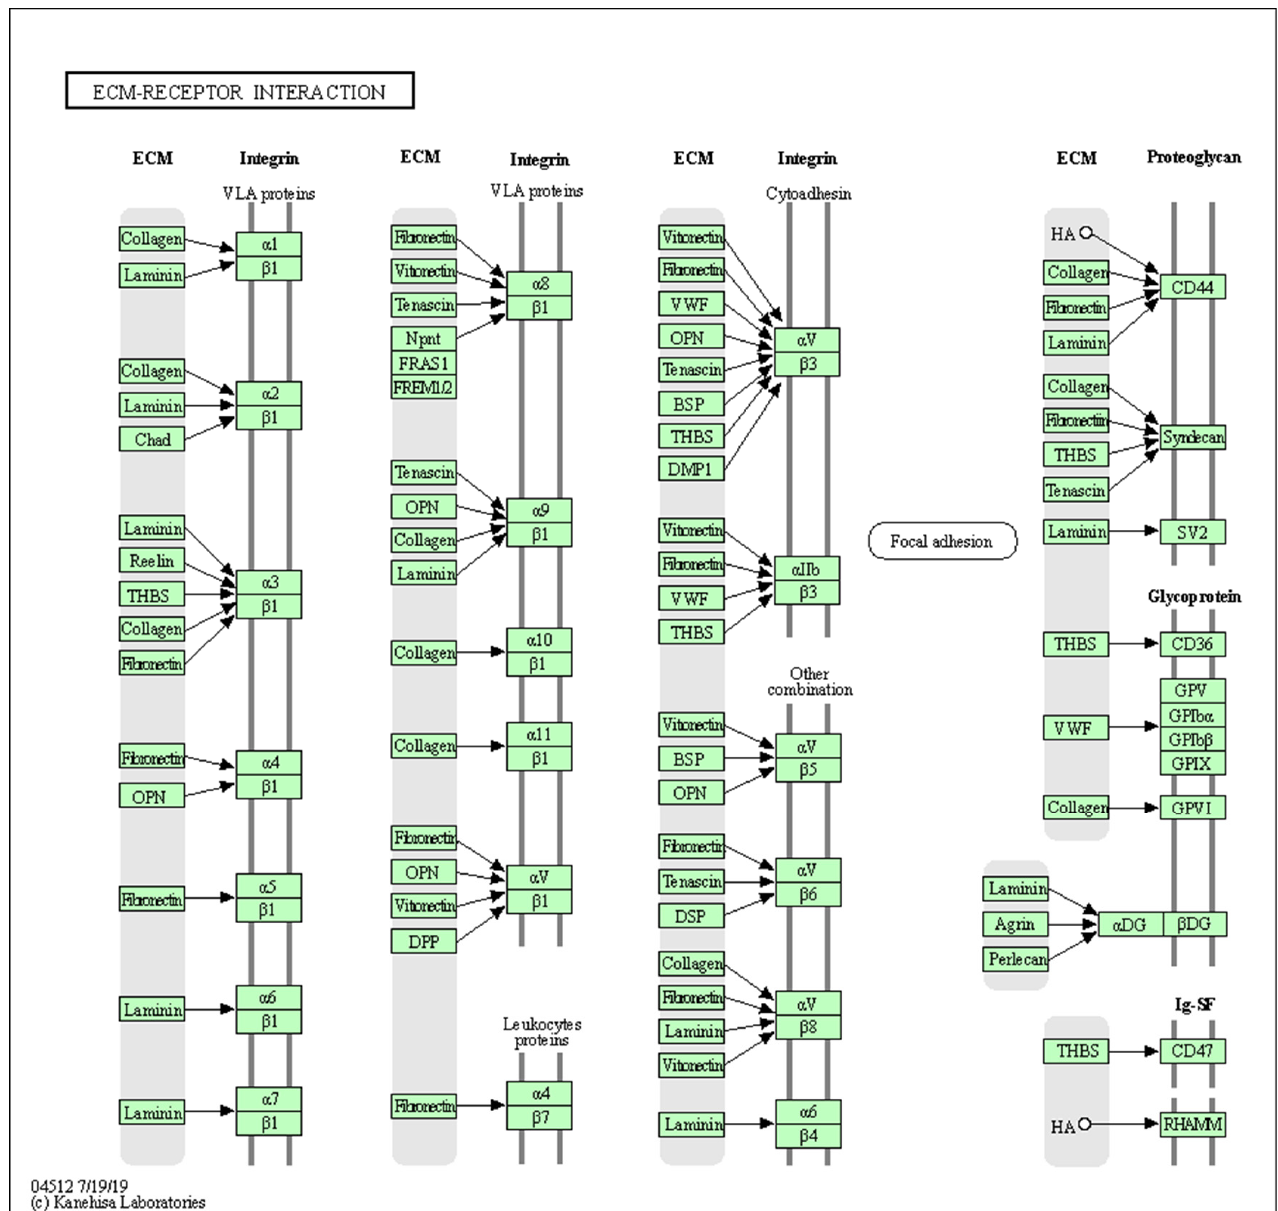
Figure A2. ECM-receptor interaction signaling pathway, KEGG pathway. KEGG, Kyoto Encyclopedia of Genes and Genomes. Copyright permission obtained.